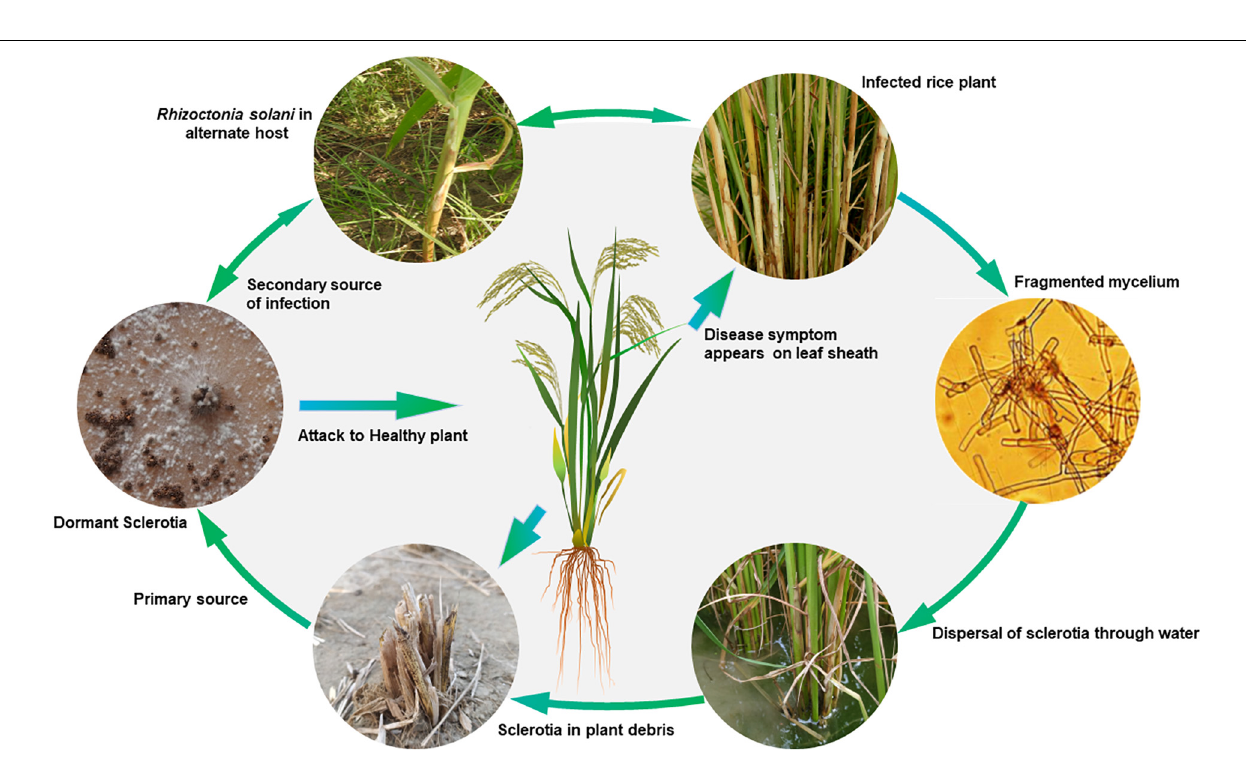
Frontiers in Plant Science |